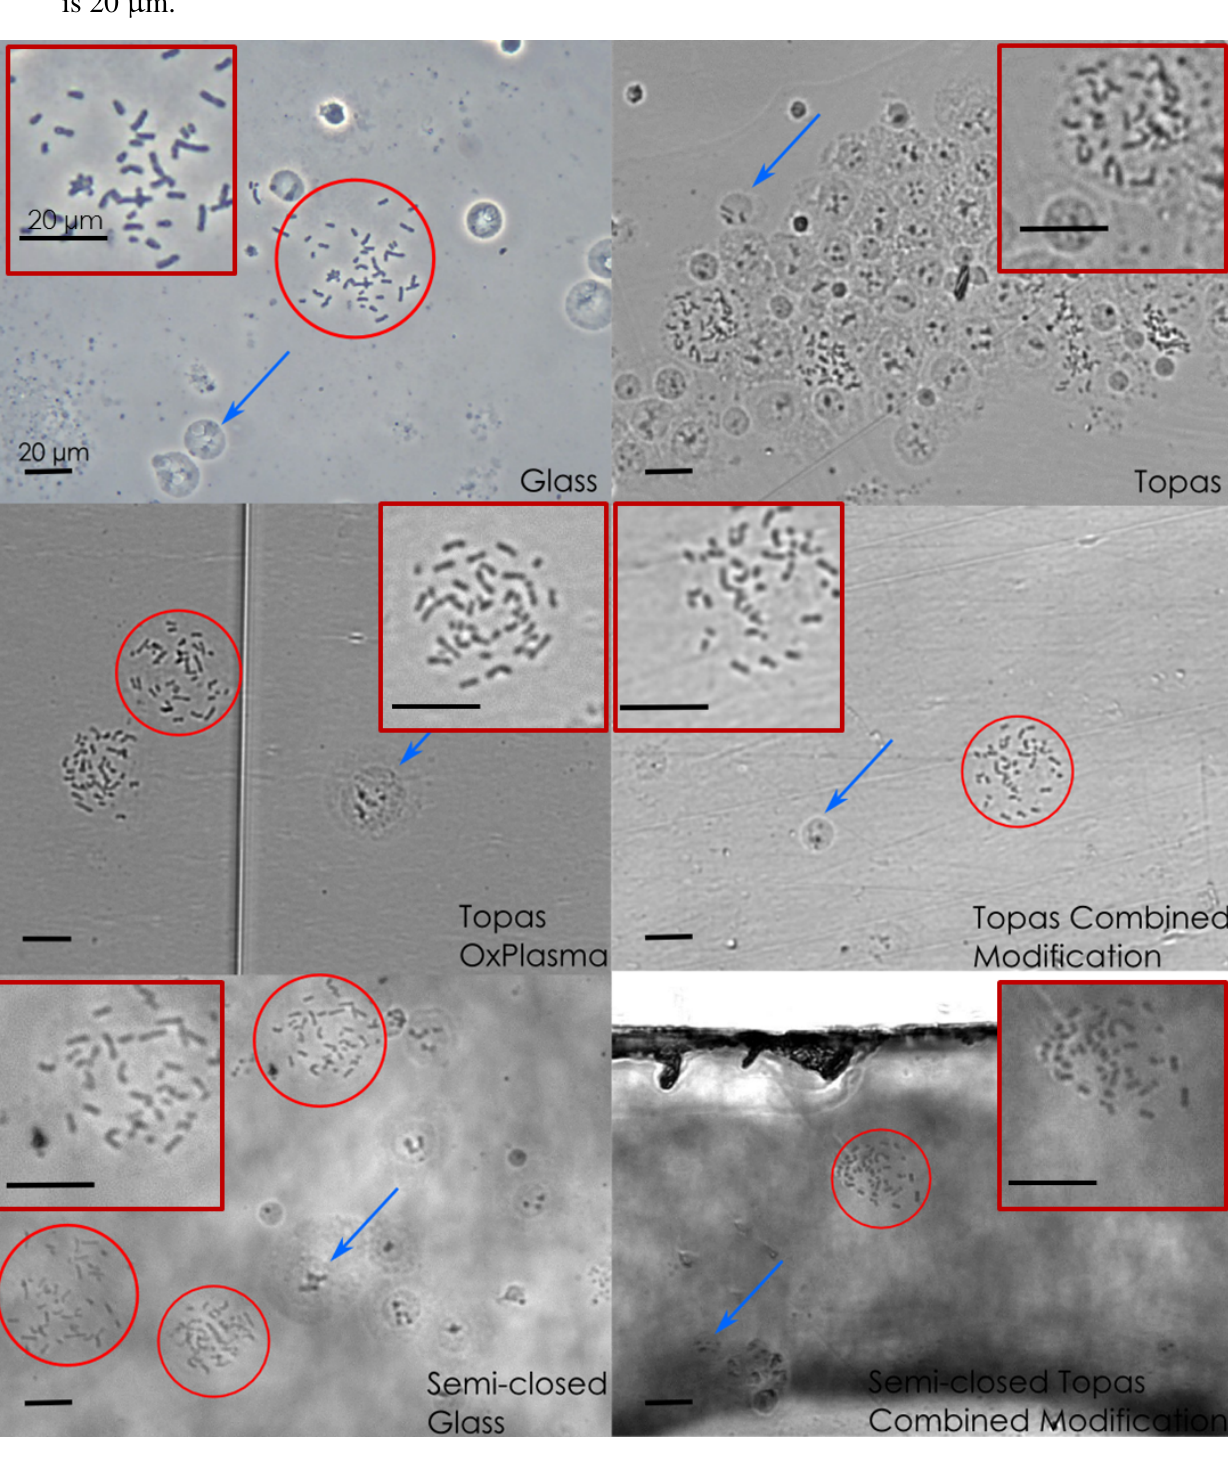
Figure 2. Chromosome spread poorly on untreated Topas (cid:114) surface (Topas), while their quality was comparable on Glass, Topas (cid:114) treated with oxygen plasma (Topas OxPlasma) and Topas (cid:114) modified with combined